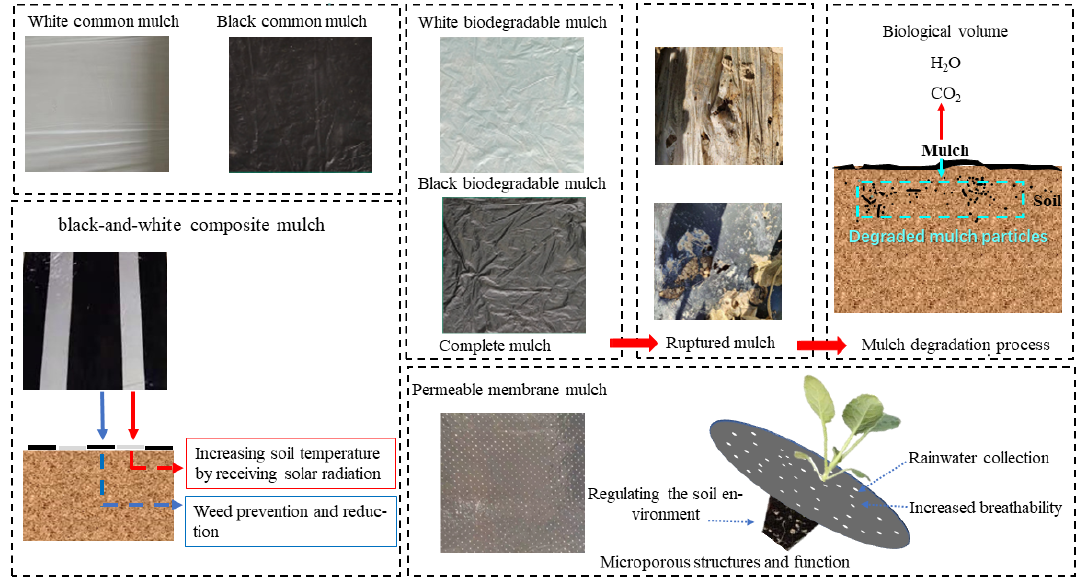
Figure 2. The functional and cosmetic characteristics of the different mulches.